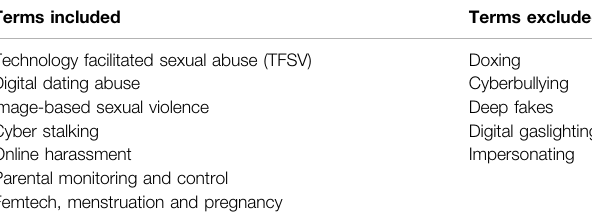
TABLE 1 | Included and excluded terms of technology facilitated